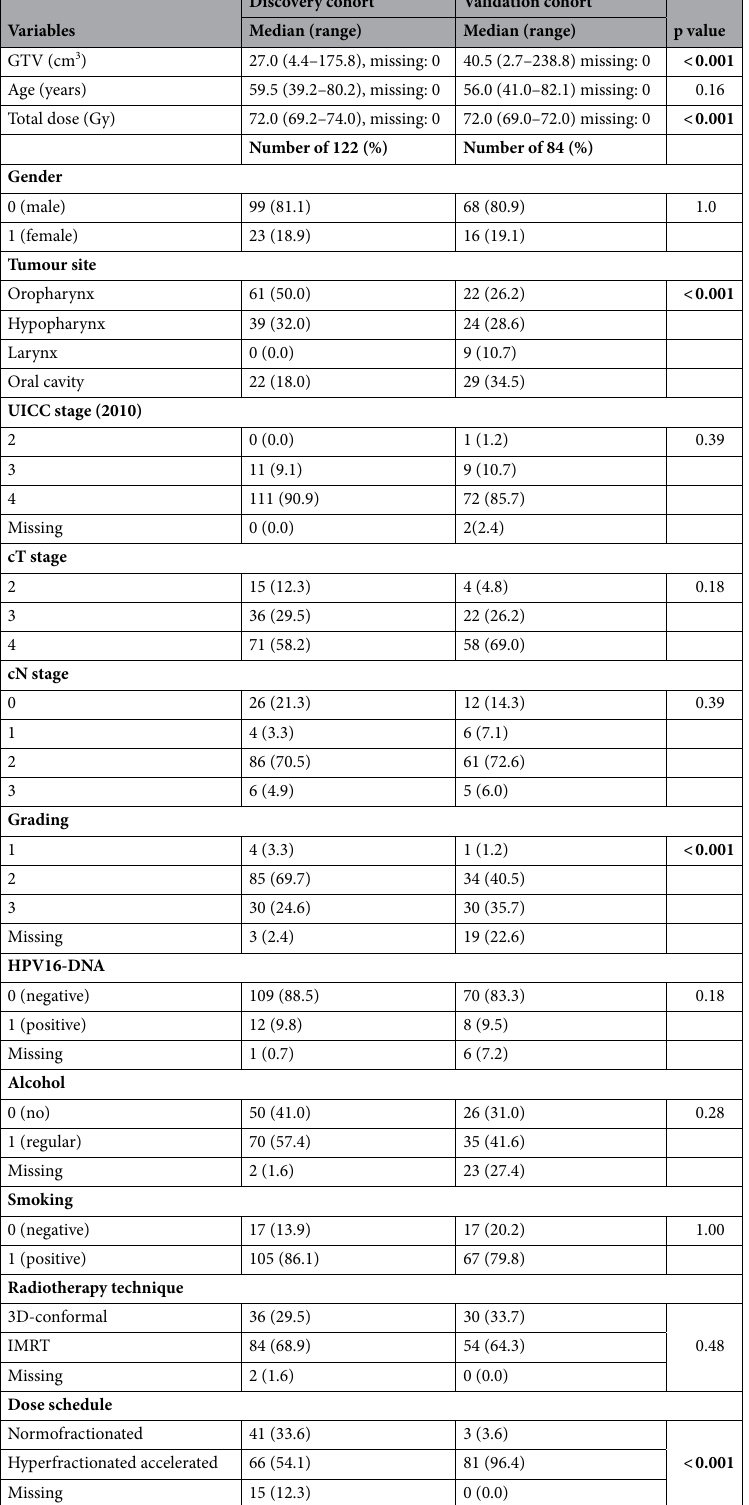
Table 1. Characteristics of clinical features for the discovery cohort (left) and validation cohort (right) along with p values for homogeneity tests between the cohorts. Abbreviations: GTV : gross tumour volume, UICC: Union for International Cancer Control, HPV16: human papillomavirus type 16, DNA: deoxyribonucleic acid, IMRT : intensity-modulated